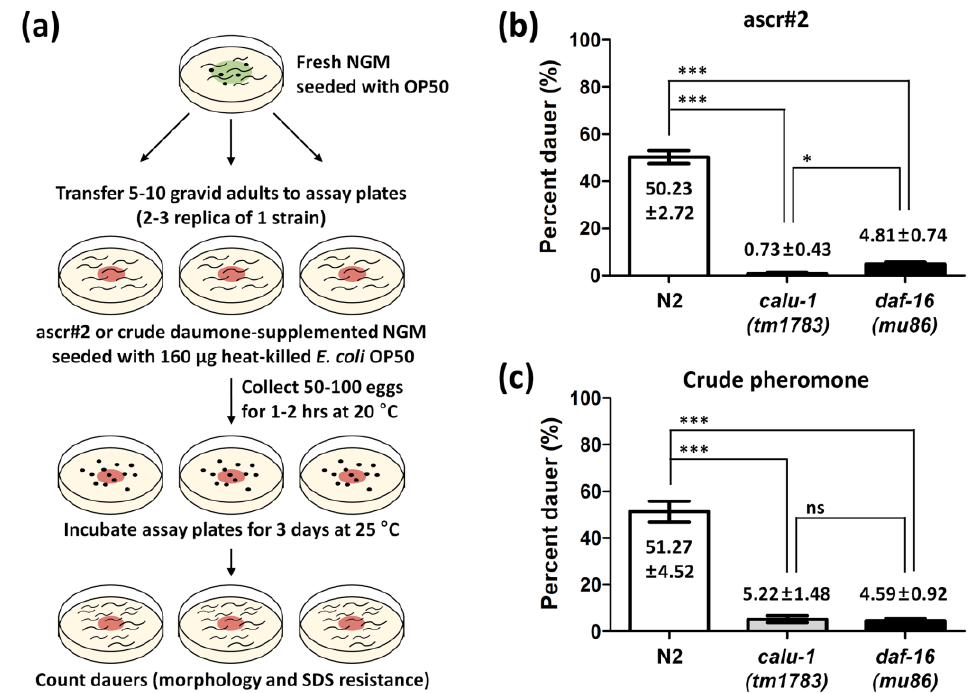
Figure 3. Dauer formation assay of the calu-1 ( tm1783 ) mutant. ( a ) Schematic diagram of the dauer formation assay. Four independent assays were performed, each in duplicate or triplicate, using ascr#2 ( b ) or crude dauer pheromone ( c ). Mean ratios with SEM (standard error of mean) are represented in bar graphs. ***, p < 0.001; *, p < 0.05; ns, not significant.